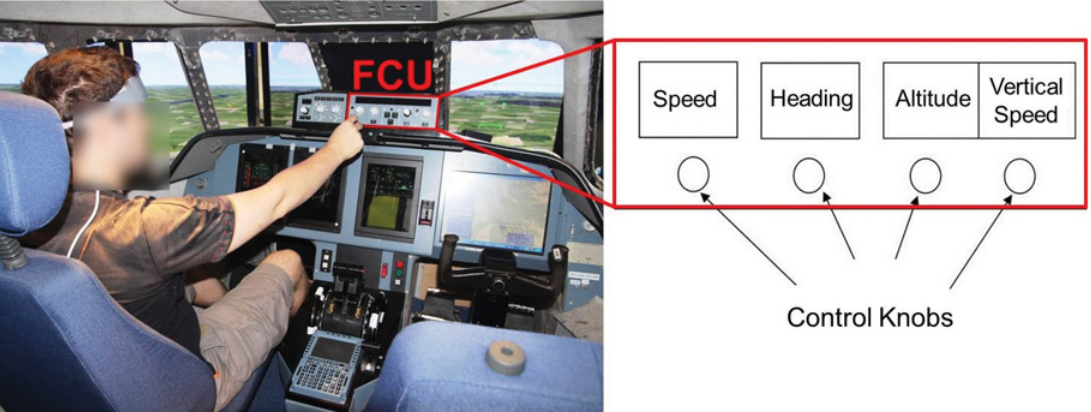
Fig 2. Pilot ’ s interaction with the FCU. The participants controlled the flight simulator from the pilot ’ s seat. The red rectangle corresponds to the FCU used to set the autopilot with four control knobs, according to ATC clearances (speed, heading, altitude, and vertical speed